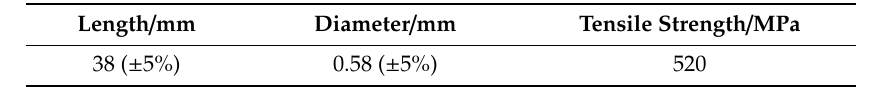
Table 2. Basic properties of steel fiber.